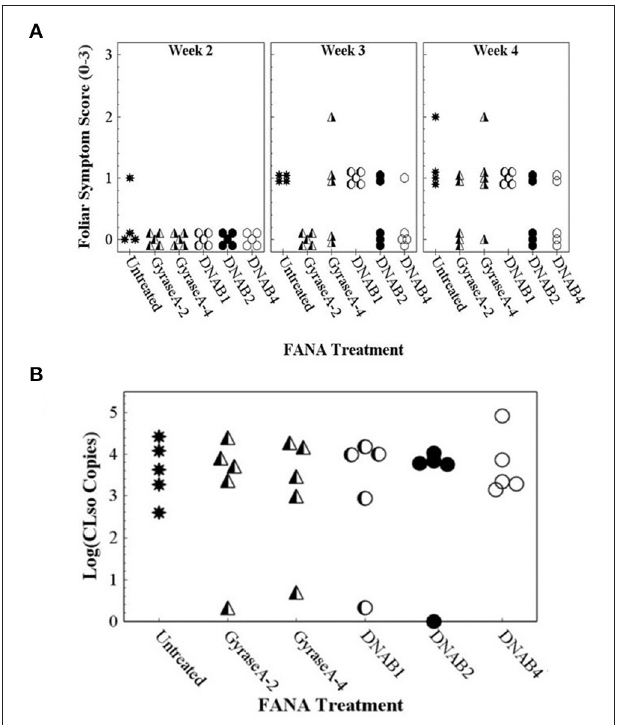
FIGURE 9 | Foliar symptom score of “0” (no symptoms) to “3” (severe leaf yellowing) observed in tomato plants 2, 3, or 4 weeks after treating the plants with water (untreated control) or FANA products (A) . Mean log number of copies of 16S gene of CLso 4 weeks after treating the tomato plants with water or FANA products (B) . Error bars represent ± SE of the